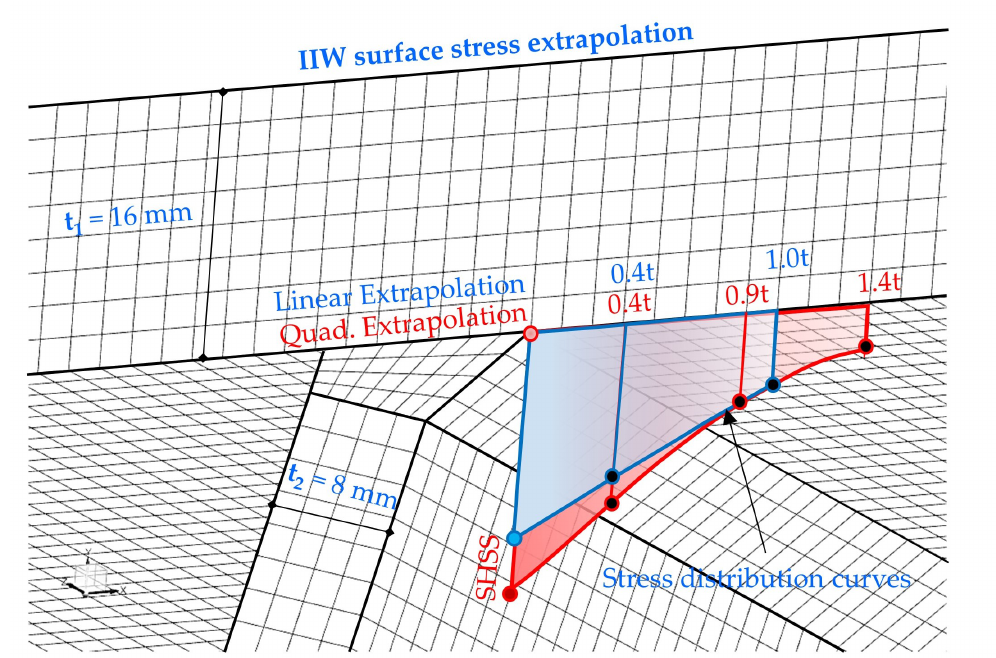
Figure 1. International Institute of Welding (IIW) surface stress extrapolation (SSE) methods for evaluation of SHSS at the weld-toe with 2.0 mm CHEXA20